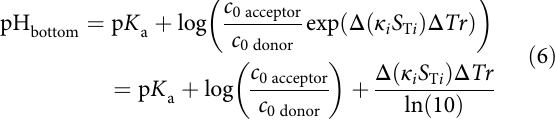
Þ ¼ κ (cid:2) κ ¼ hw (cid:2) 1 acceptor S T acceptor donor S T donor and r the aspect ratio of the chamber. By assuming κ acceptor ≈ κ donor and 1/ln(10) ≈ 0.43, pH bottom is given by (cid:3) pH þ 0 : 43 κ S (cid:2) S pH T acceptor T donor bottom init